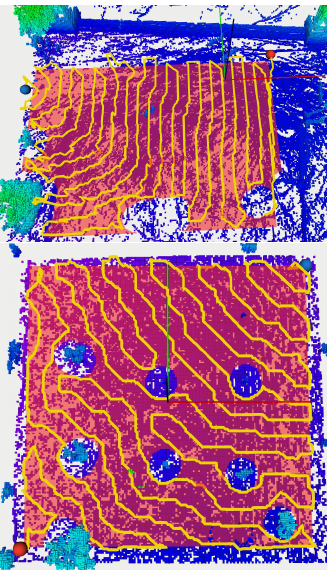
Figure 22. Top view of the three scenarios: represented as Octomaps (voxels in green-blue tones according to Z-axis coordinate). Yellow line represents the flight trajectory for the drone at 1.5 ± 1 m from the ground. Red plane represents free-to-fly areas. Scenarios: Local A ( top-left ), B ( top-right ) and C ( bottom ).